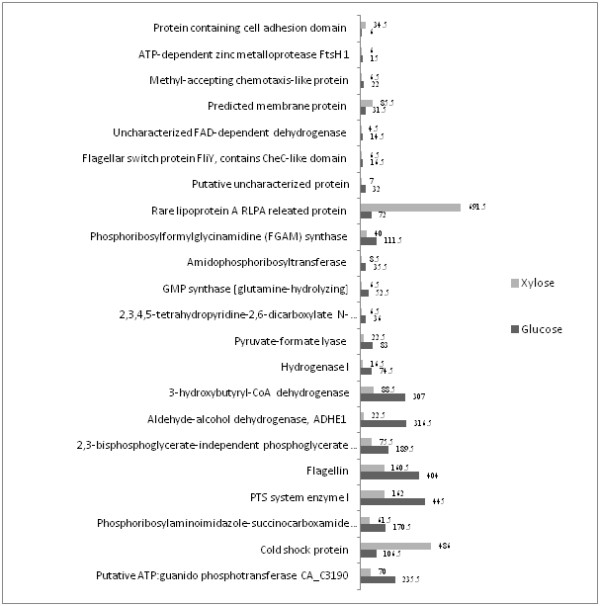
Differentially expressed proteins identified from ABE fermentation between glucose and xylose substrates based on the spectral counting method with the spectral score shown at the end of each bar.